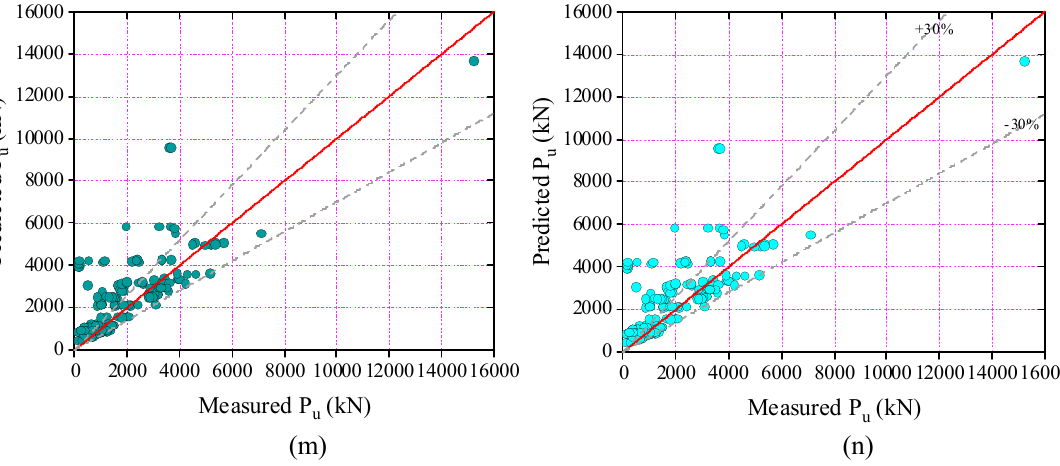
Figure 6. Results of analytical models: ( a ) Model-8, ( b ) Model-1, ( c ) Model-2, ( d ) Model-9, ( e ) Model-3, and ( f ) Model-10, ( g ) Model-4, ( h ) Model-11, ( i ) Model-5, ( j ) Model-12, ( k ) Model-13, and ( l ) Model-6, ( m ) Model-7, and ( n ) Model-14.